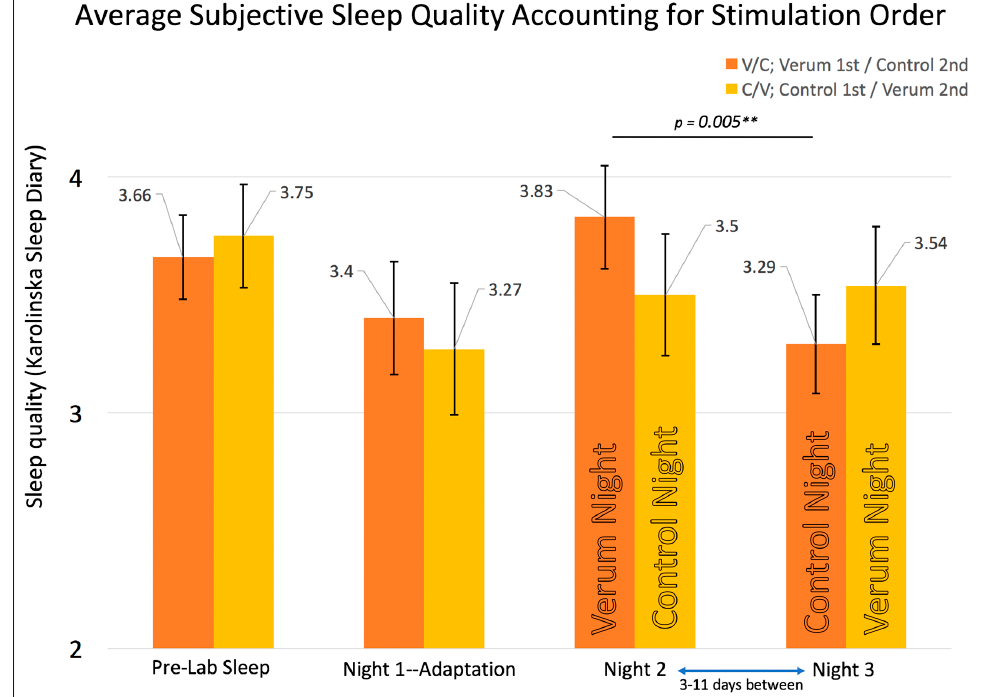
Figure 3. Shows the repeated measures effects of sleep quality while accounting for counterbalancing of stimulation condition order. The omnibus multivariate F was significant at p = 0.042. Error bars represent +/- 1 standard error of the mean. Significant differences were found between the verum and control nights only for the group receiving verum stimulation on Night 2 (namely, the Verum/Control V/C group), with a double asterisk “**” indicating p = 0.005 for an individual, uncorrected